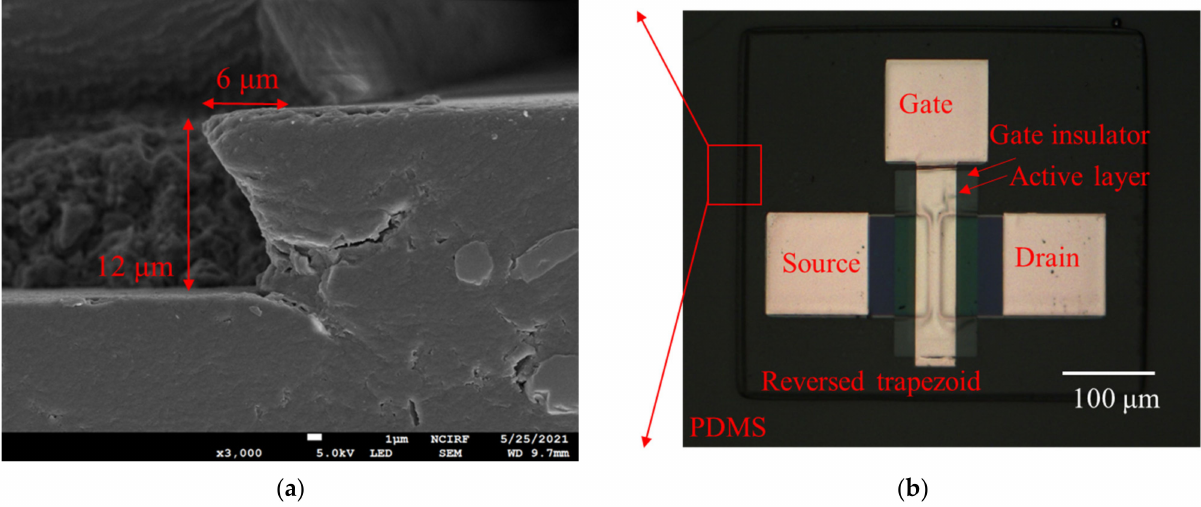
Figure 2. Micrograph images of fabricated stretchable a -IGZO TFTs. ( a ) An SEM image for edge of reverse-trapezoid structure. ( b ) An image of fully fabricated stretchable a -IGZO TFTs on the reverse-trapezoid